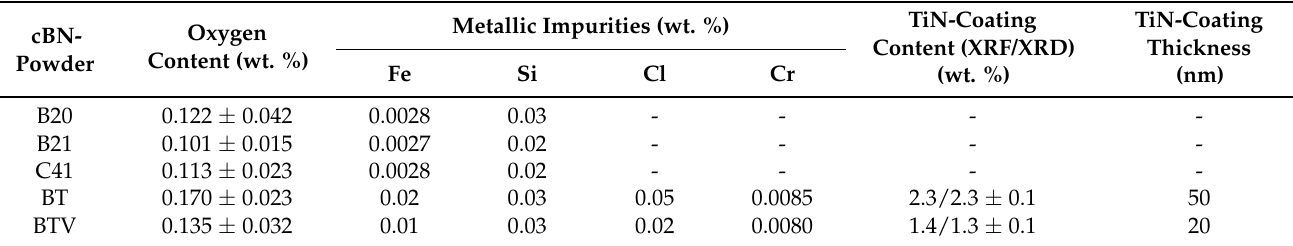
Table 1. Properties of the used cubic boron nitride (cBN) powders and TiN coated cBN powders regarding oxygen content, metallic impurities, coating content and coating thickness (the TiN content was determined by XRF measurement of Ti and